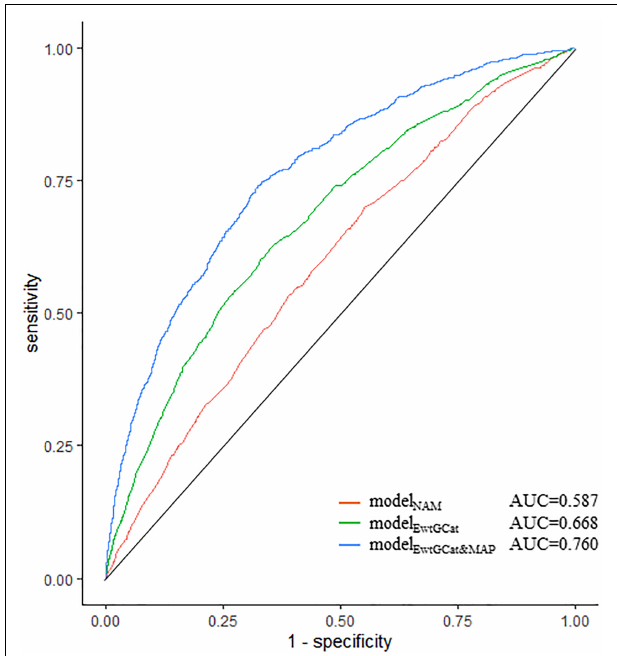
FIGURE 4 | The predictive capacity of prediction models for HDP. The ROC plot demonstrated the predictive capacity of prediction models. The model NAM , model EwtGCat , and model EwtGCat & MAP were presented in red, green, and blue curves, respectively. The model NAM included NAM criteria; model EwtGCat included EwtGCat, model EwtGCat & MAP was consisted of EwtGCat, MAP 13 week , MAP 2 week . All the models were adjusted by race, age, level of education, employment condition, maternal age ( > 35 age), gestational